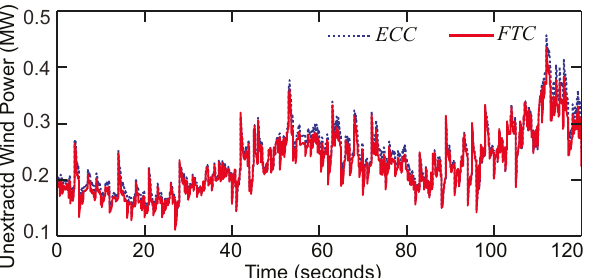
Figure 6. The unextracted wind power due to the transients in reference tracking of the FTC and the ECC.